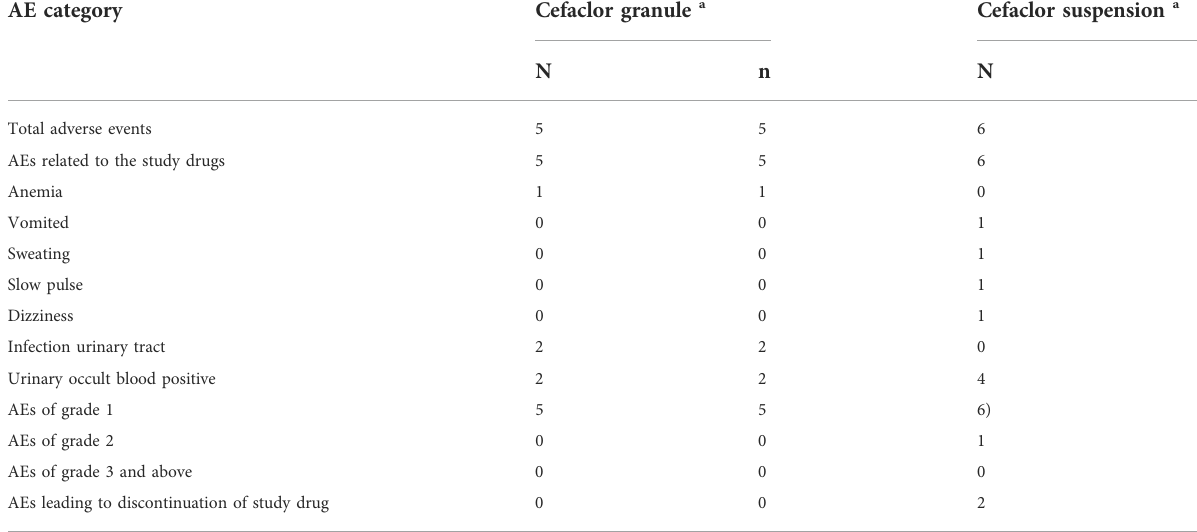
TABLE 5 Summary of AEs for Cefaclor granule and Cefaclor suspension in the fasting